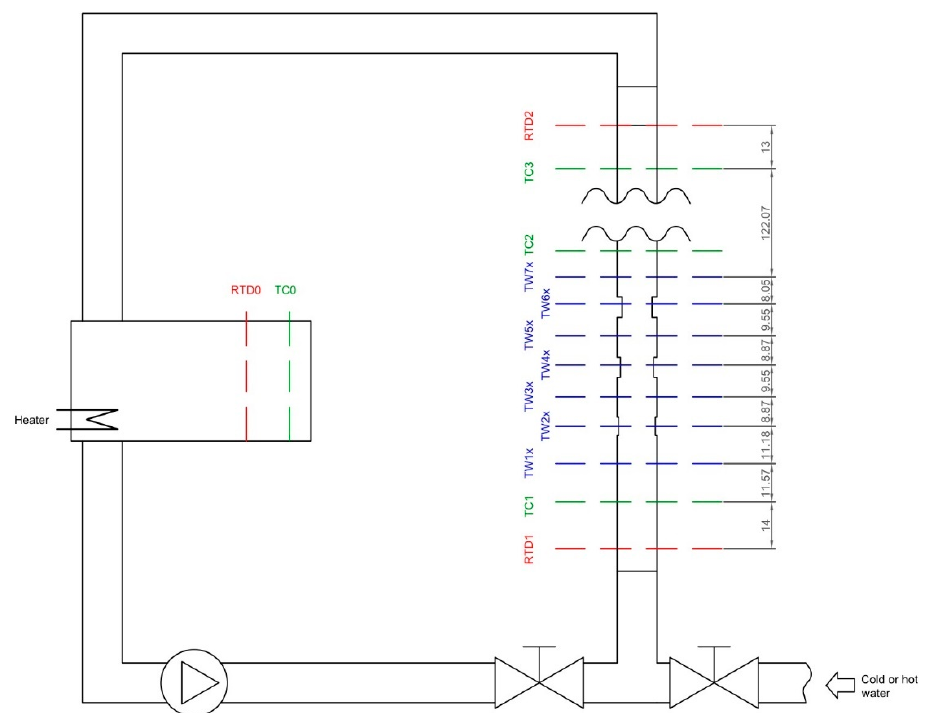
Figure 3. Diagram of the measuring stand, with marked locations of temperature sensors and places of narrowing in pipe wall thickness.